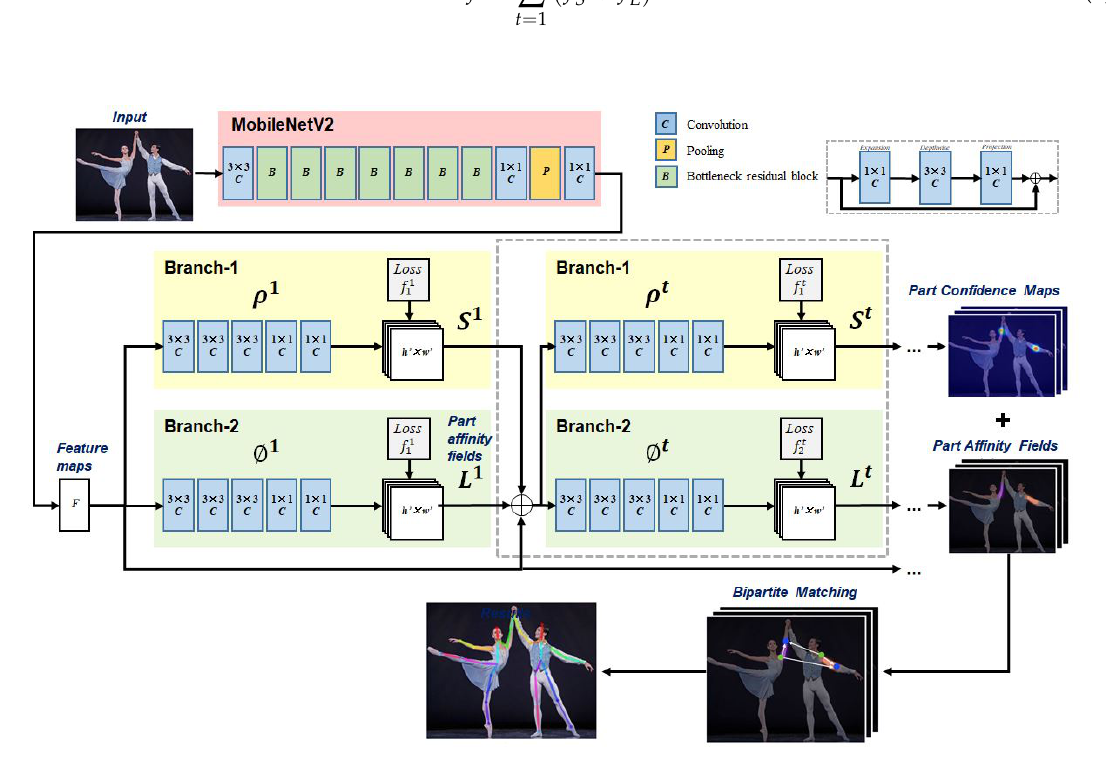
Figure 2. Architecture of the OpenPose Model to extract the body parts’ keypoints of the person detected in